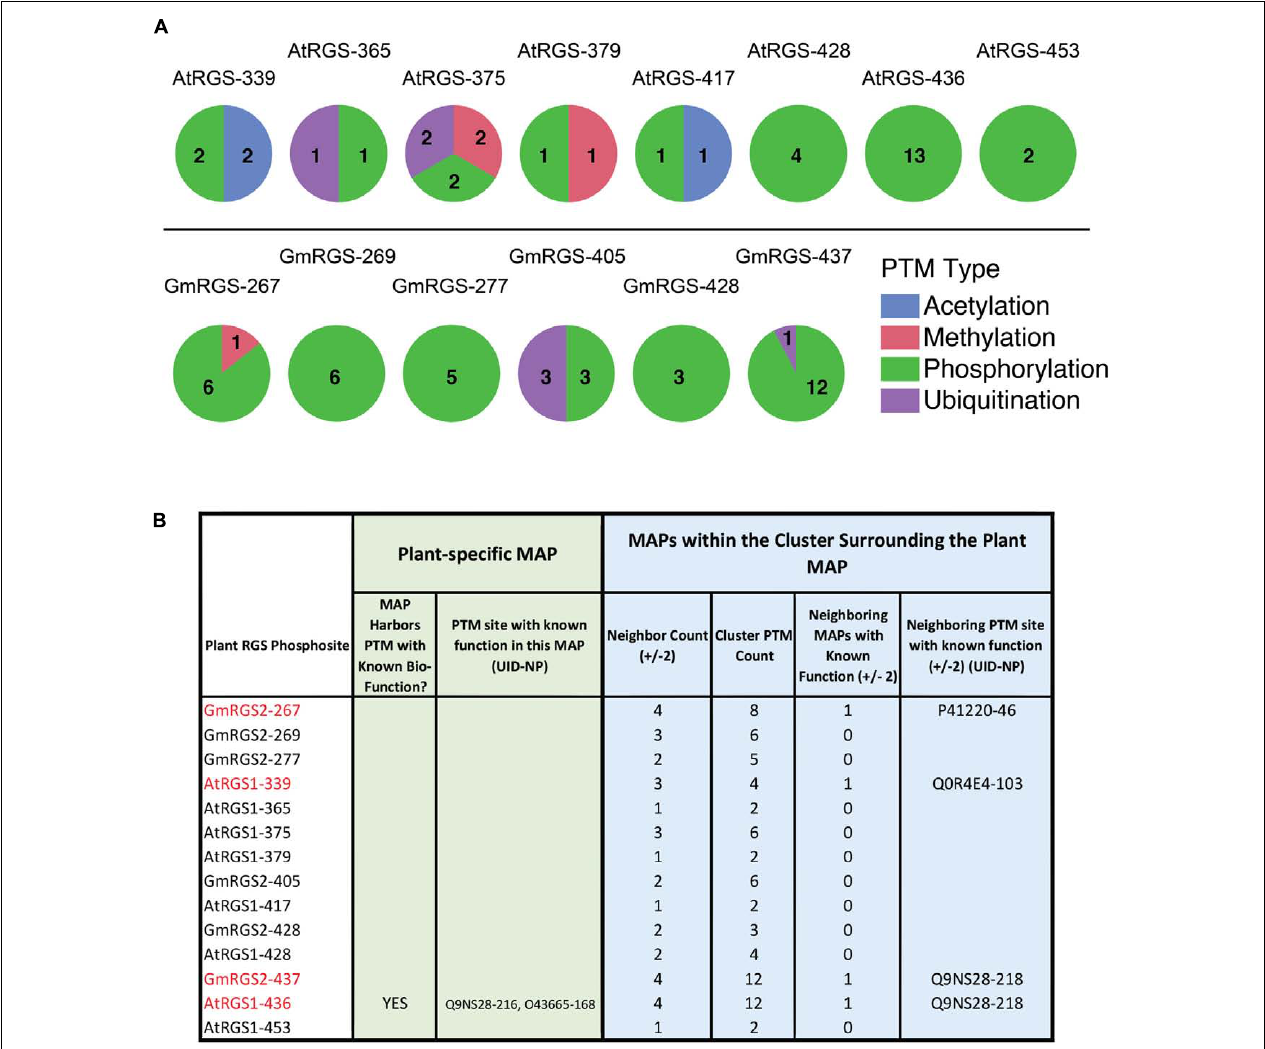
FIGURE 4 | Post-translational modification cluster characteristics of plant phosphosites. (A) PTM types observed in PTM clusters surrounding each of the 14 plant MAPs. (top) AtRGS1-specific cluster analysis. (bottom) GmRGS2-specific cluster analysis. Numbers correspond to the number of unique PTMs found in each cluster (by PTM type). (B) Table showing the specific cluster characteristics for each plant phosphosite, including those within close proximity to biologically functional PTMs in non-plant RGS proteins. Neighbor count corresponds to the number of MAPs within ± 2 alignment positions of the plant MAP (maximum = 4). Cluster PTM count corresponds to the total number of PTMs observed within ± 2 alignment positions of the plant MAP. Neighboring MAPs with known function corresponds to a binary classifier for proximal functional PTMs (0 = NO, 1 = YES). UID, UniProt ID; NP, native position of the modified residue.